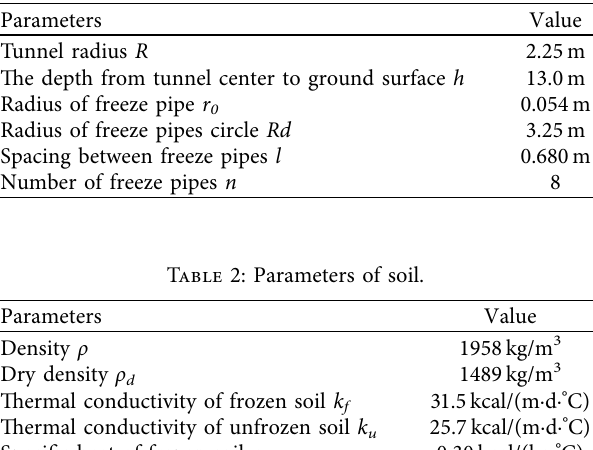
Table 1: Parameters of the tunnel.